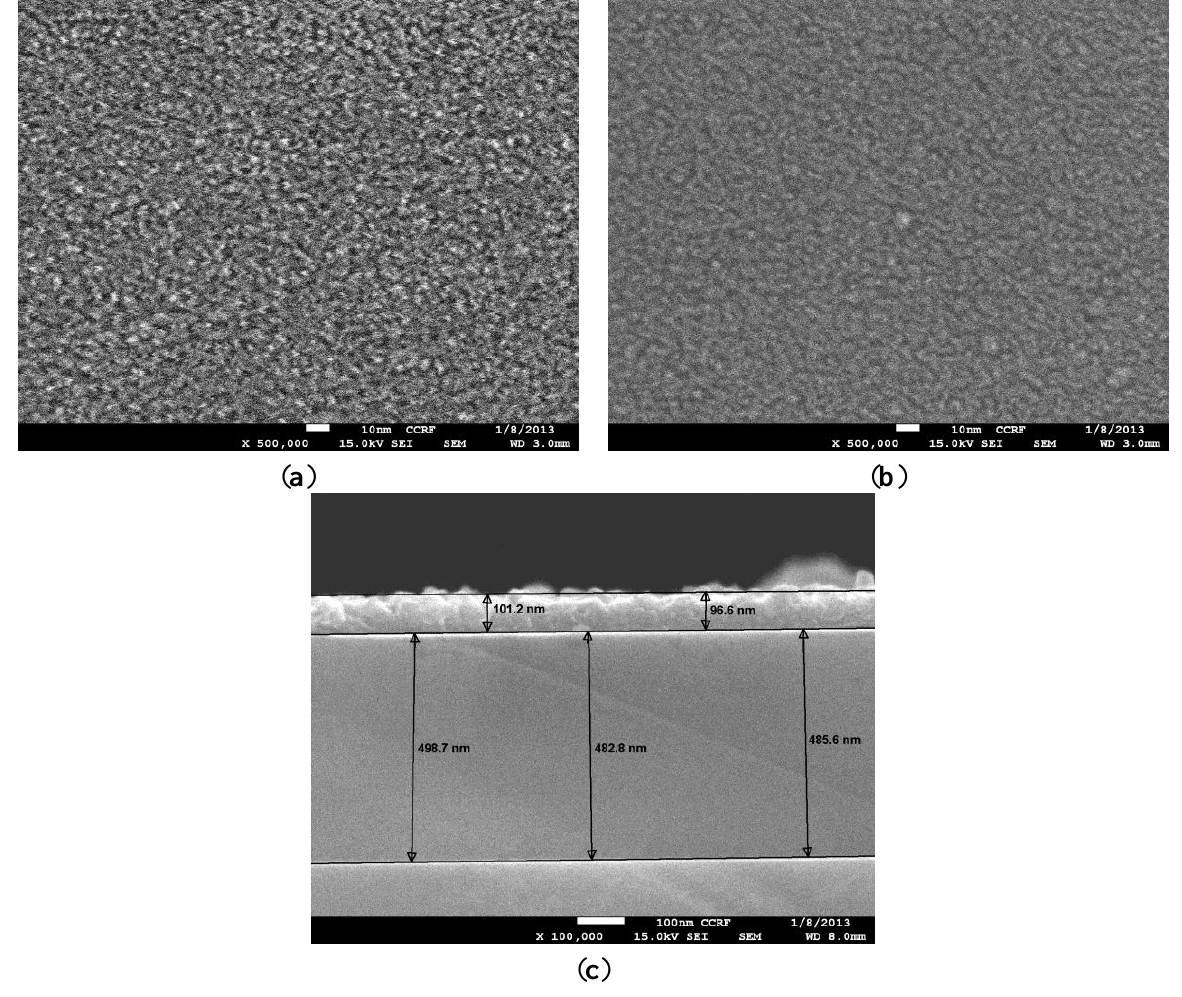
( c ) Cross-sectional SEM image of polymer sample for thickness